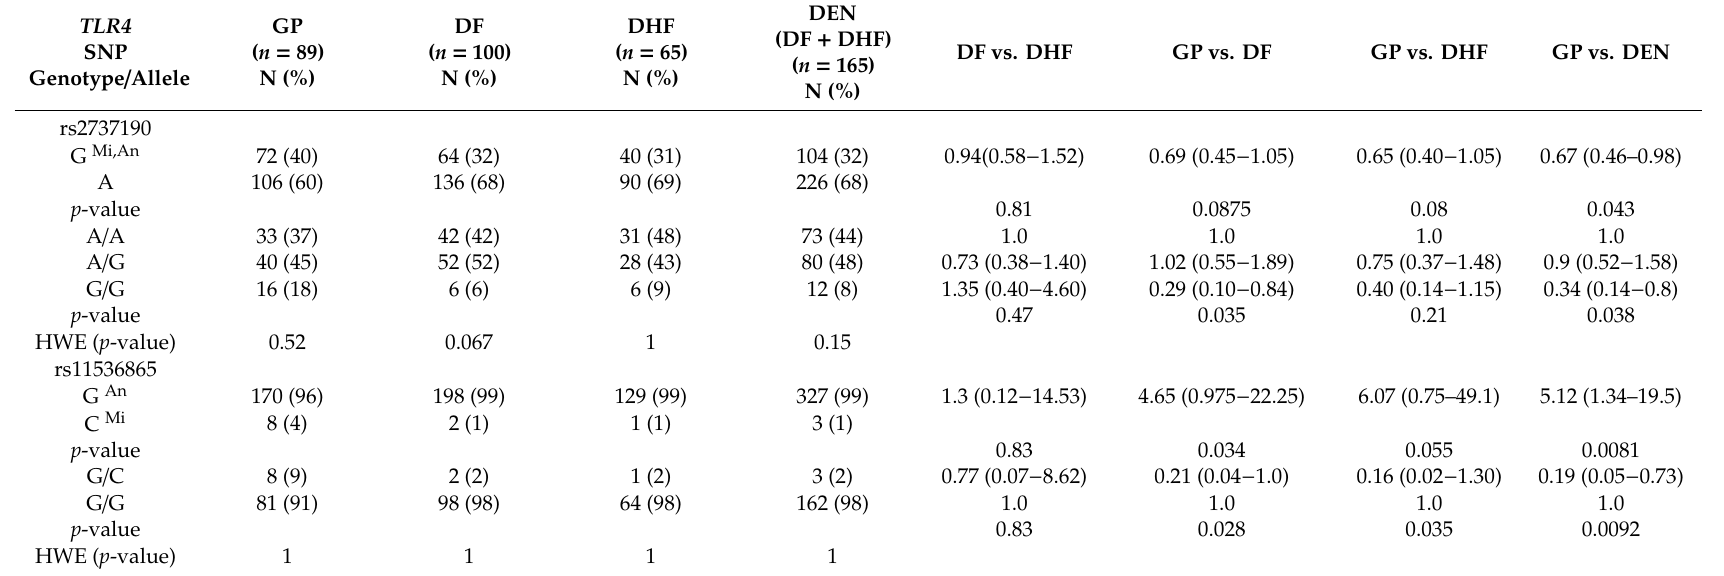
Table 3. Allelic and genotypic frequencies of TLR4 -rs2737190 and TLR4